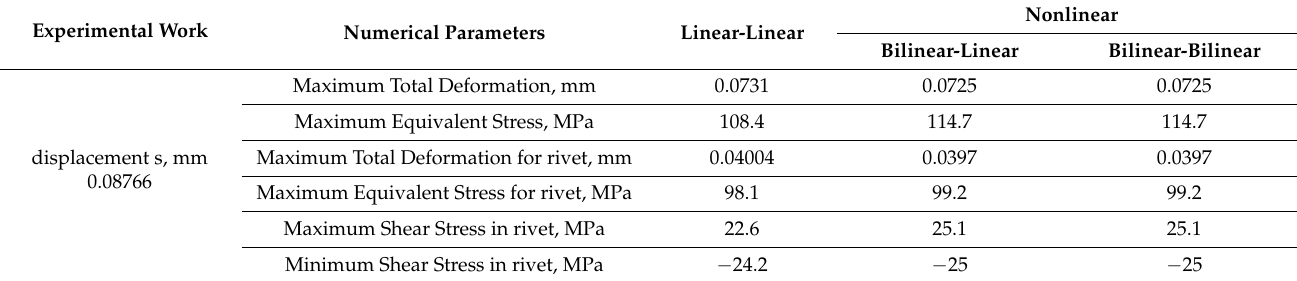
Table A2. Experimental and numerical results for the load force F = 200 N.